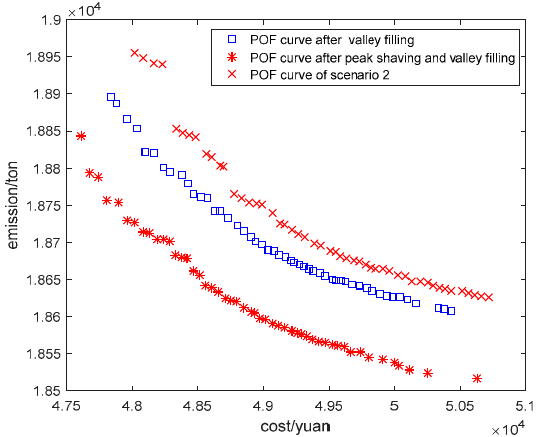
Figure 9. Scheduling results of three strategies.